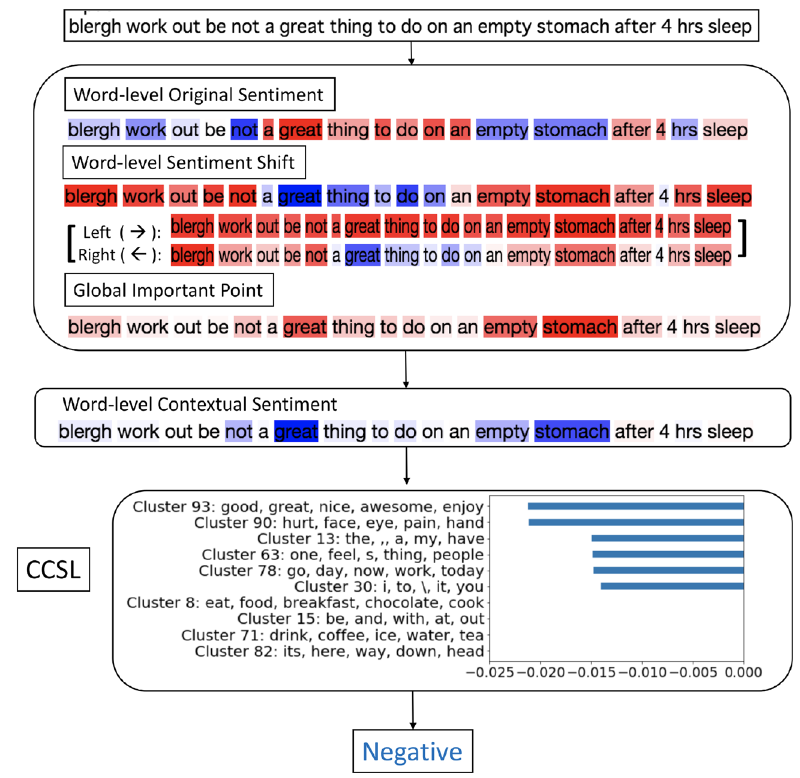
Fig. 4 Text-visualization Example for an English review in Sentiment 140. The color and depth of terms mean polarity 0 0 (red: > and blue: < ) and scale of word-level sentiments in each